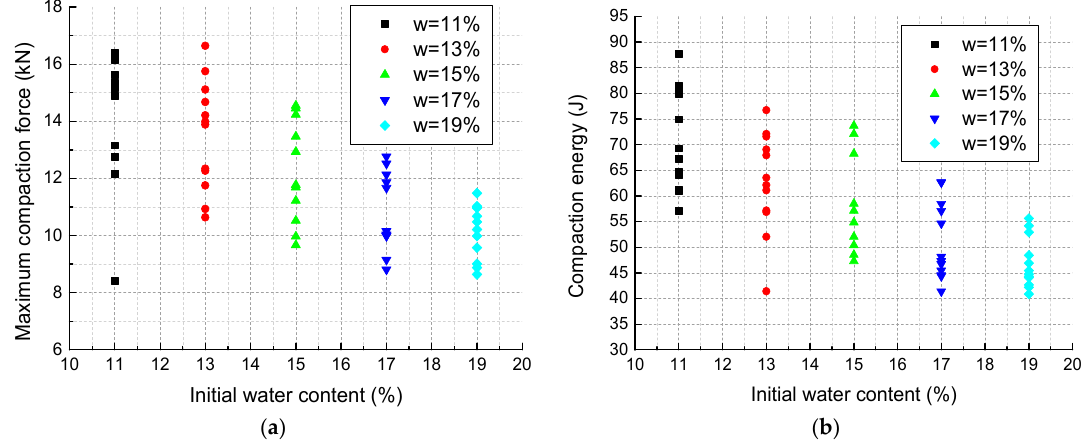
Figure 9. Results of static compaction test: ( a ) maximum compaction force; ( b ) compaction energy.